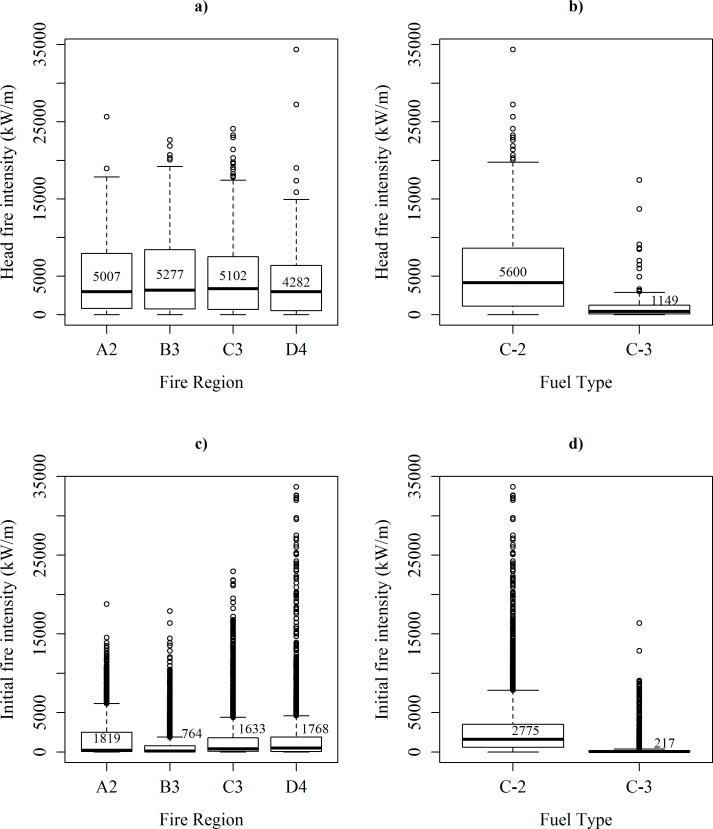
Distribution of the historical and initial fire intensities by fire region and fuel type.Boxplots summarizing the distribution of the recorded historical head fire intensities (kW m-1) for a) fire region, b) fuel type, and the distributions of initial fire intensities (Ii, kW m-1) for c) fire region, and d) fuel type. Mean values are shown within the boxes. Boxes represent the inter-quartile ranges; horizontal lines within the boxes represent medians; whiskers extend to the most extreme data point that is no more than 1.5 times greater than the 3rd quartile or less than the 1st quartile. Dots above whiskers represent extreme values.